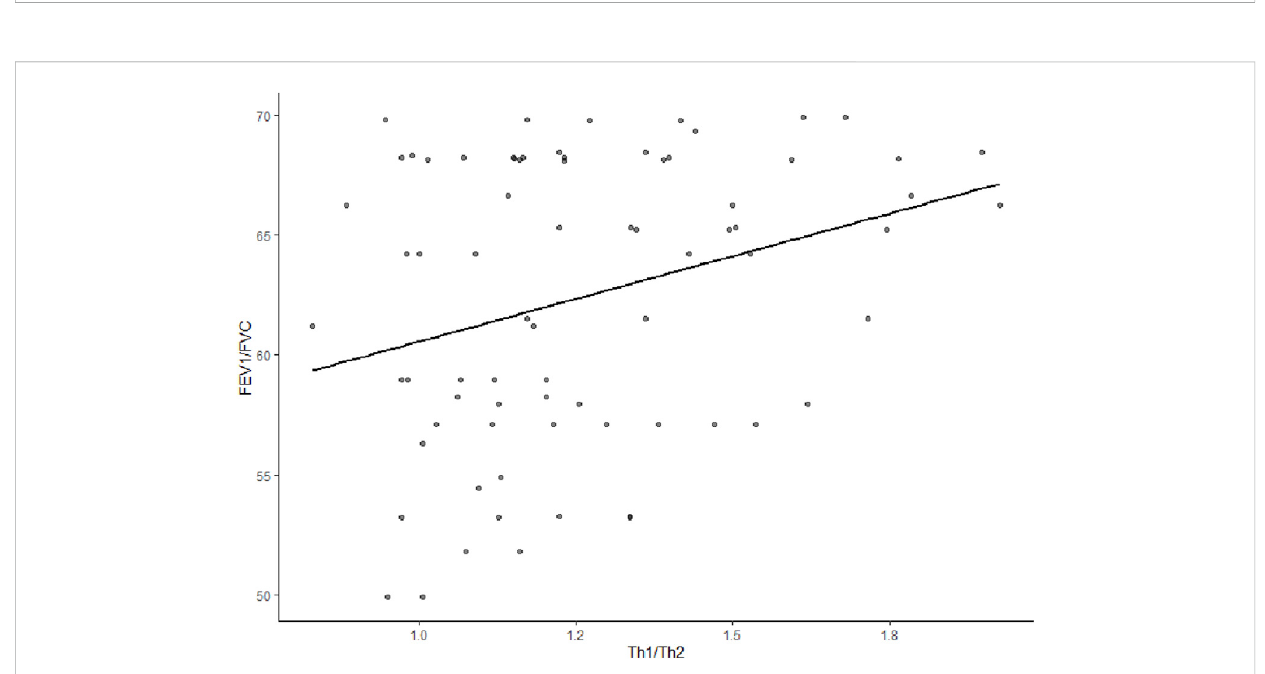
Correlation analysis between Th1/Th2 cytokines and FEV1/FVC in early COPD. The r (correlation coef fi cient) was 0.273( p = 0.018), indicating a positive correlation between Th1/Th2 cytokines and